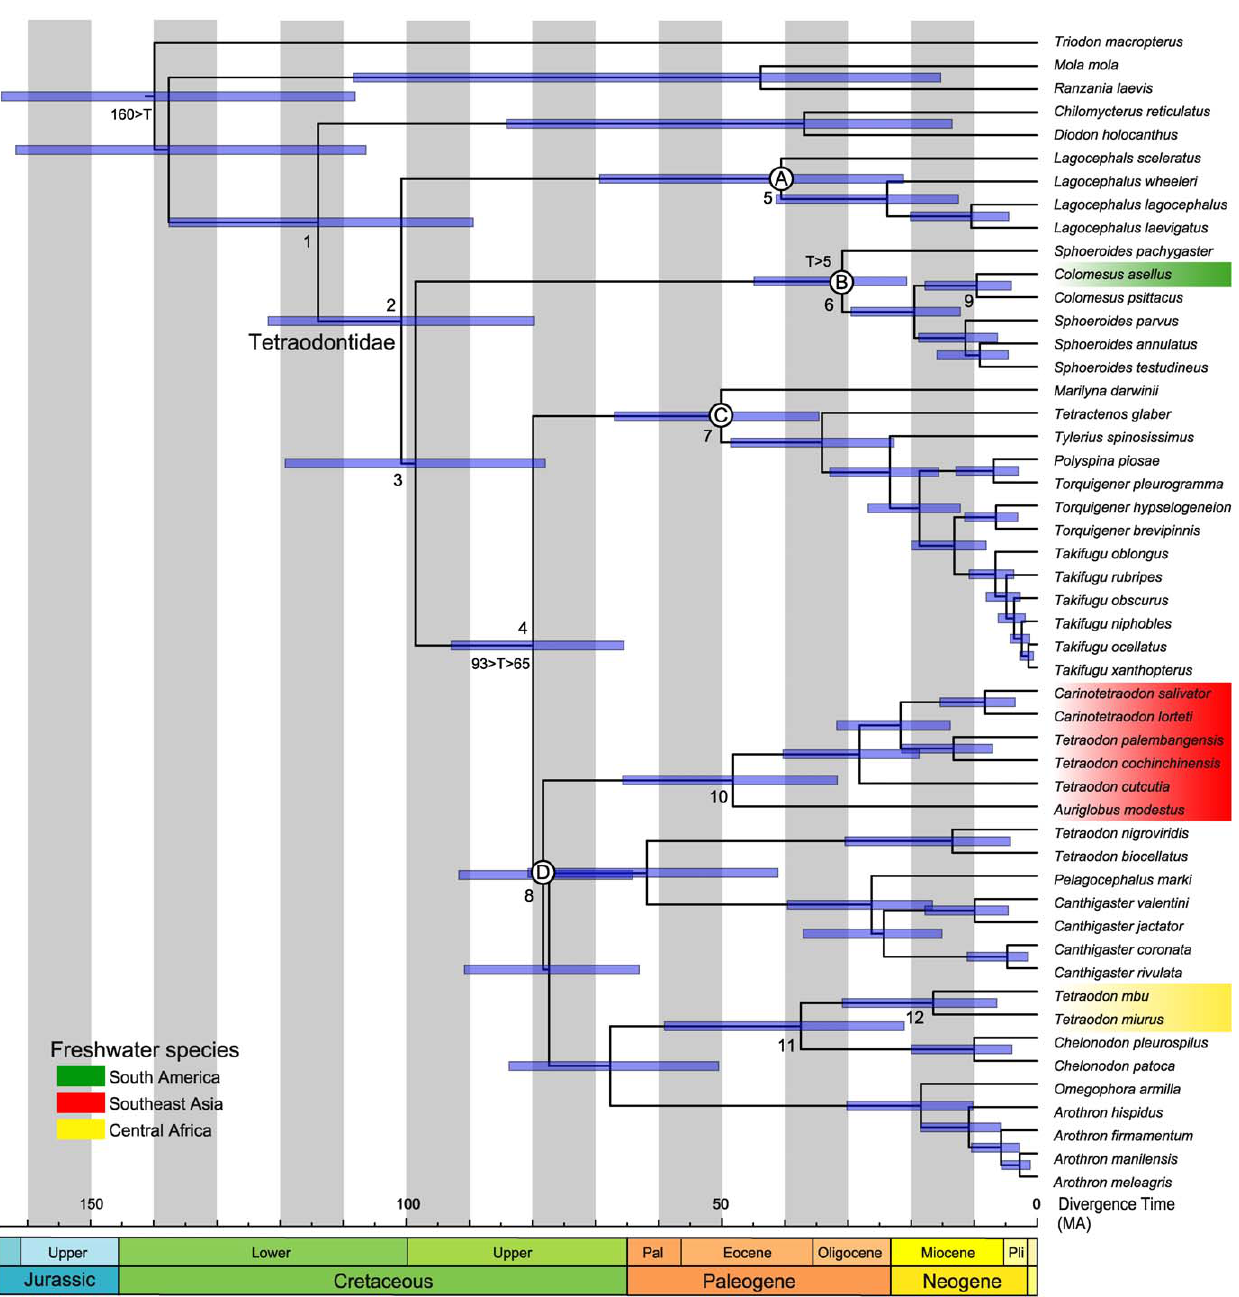
Figure 4. Divergence times among tetraodontid pufferfishes from the relaxed-molecular clock method with the dataset 12 n RT n . Node numbers 1–12 and three time constraints are indicated above and below nodes, respectively. Horizontal bars indicate 95% credible intervals of the divergence time estimates.